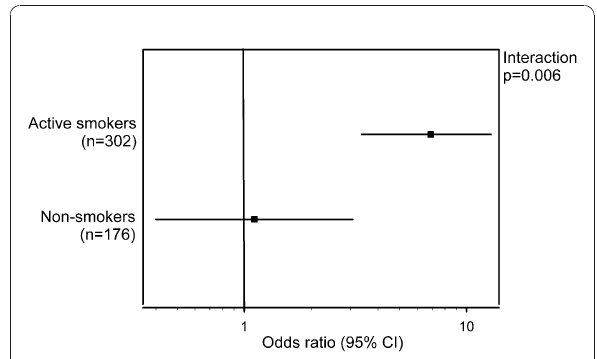
Figure 1 HNF1A G319S and incident type 2 diabetes stratified by active cigarette smoking . Odds ratios are adjusted for age, sex, hypertension, triglyceride, and waist circumference. The distributions of S319 carriers within smokers and non-smokers were 55/303 (18.2%) and 38/176 (21.6%) and were not statistically different (p =